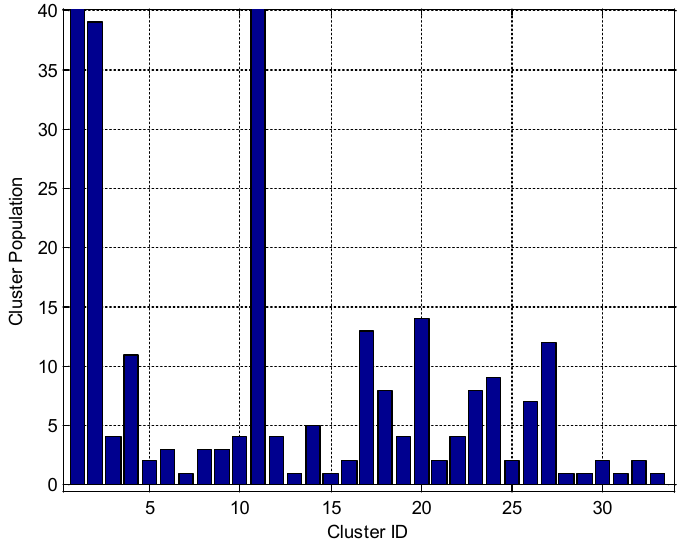
Figure 4. Population of each cluster identified by the MIRGKL algorithm.